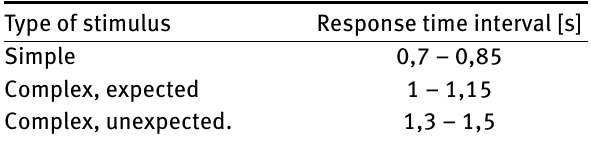
Table 1: Average response times to different types of stimuli